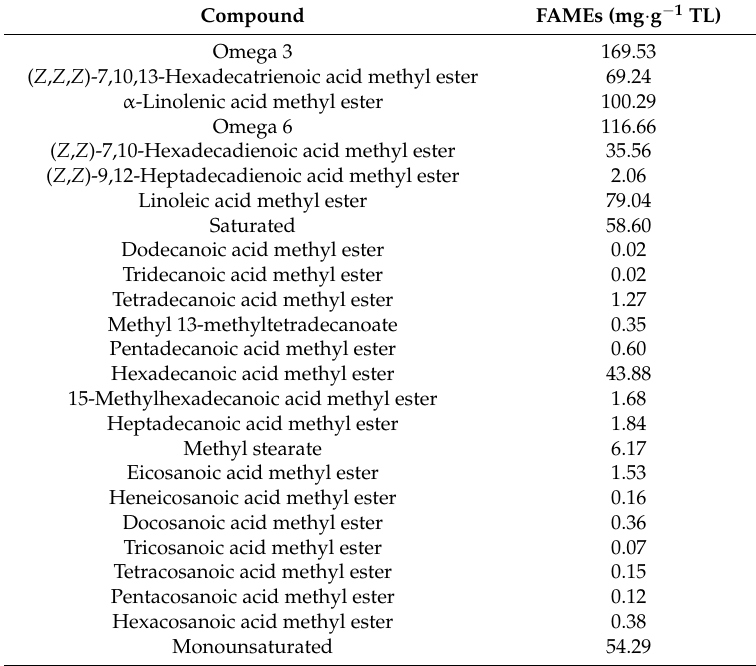
Table 2. FAMEs of the TL fraction extracted from Chlorella sorokiniana